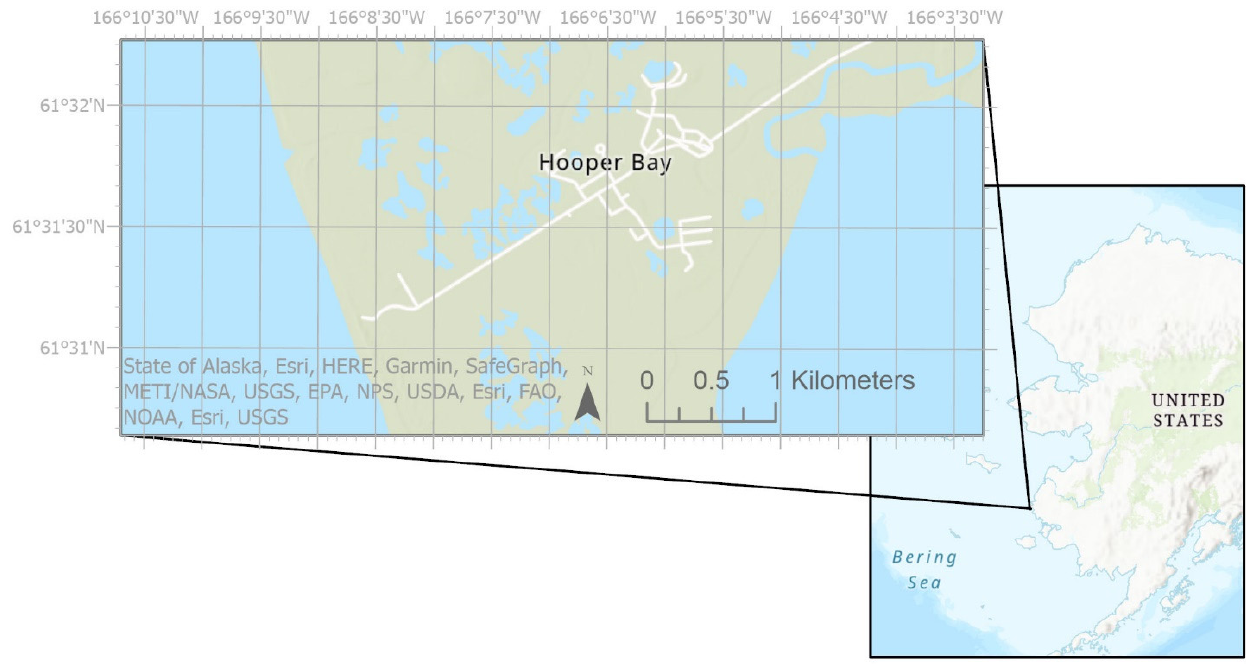
Figure 1. Location and Map of Hooper Bay.